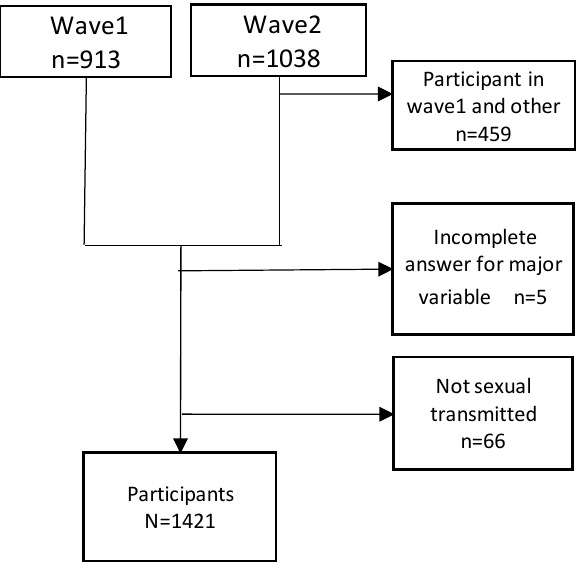
Figure 1. Flow chart of participants in this study.